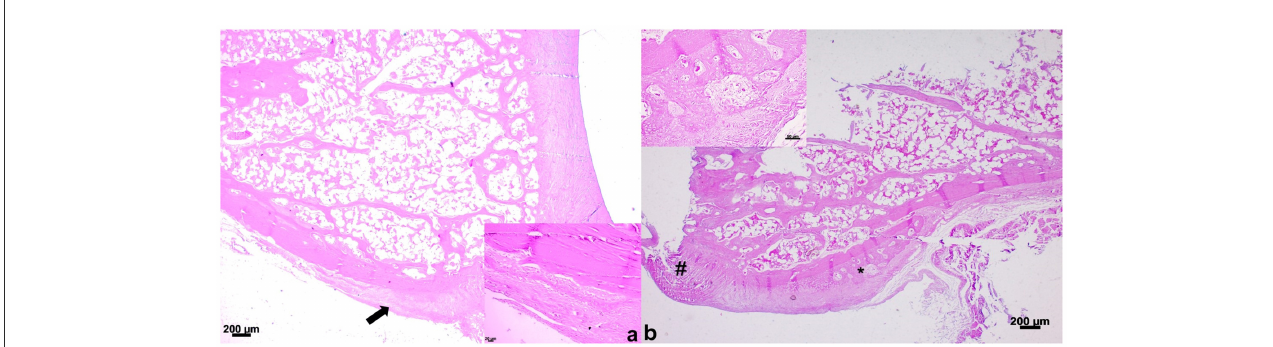
FIGURE6 (a) Proximal fractured end of the radius in a chicken of Group 2 on day 21 after surgery. Observe slight thickening (arrow) of the periosteum (HE, 10x); Insertion—Note a slight proliferation of bone tissue under the periosteum (HE, 20x). (b) Distal fractured end of the radius in a chicken of Group 2 on day 21 after surgery. Observe disorganized and fibrillary material (hashtag), and periosteal new bone (asterisk) (HE, 10x). Insertion—Note a moderate proliferation of bone and vascular tissue under the periosteum (HE,